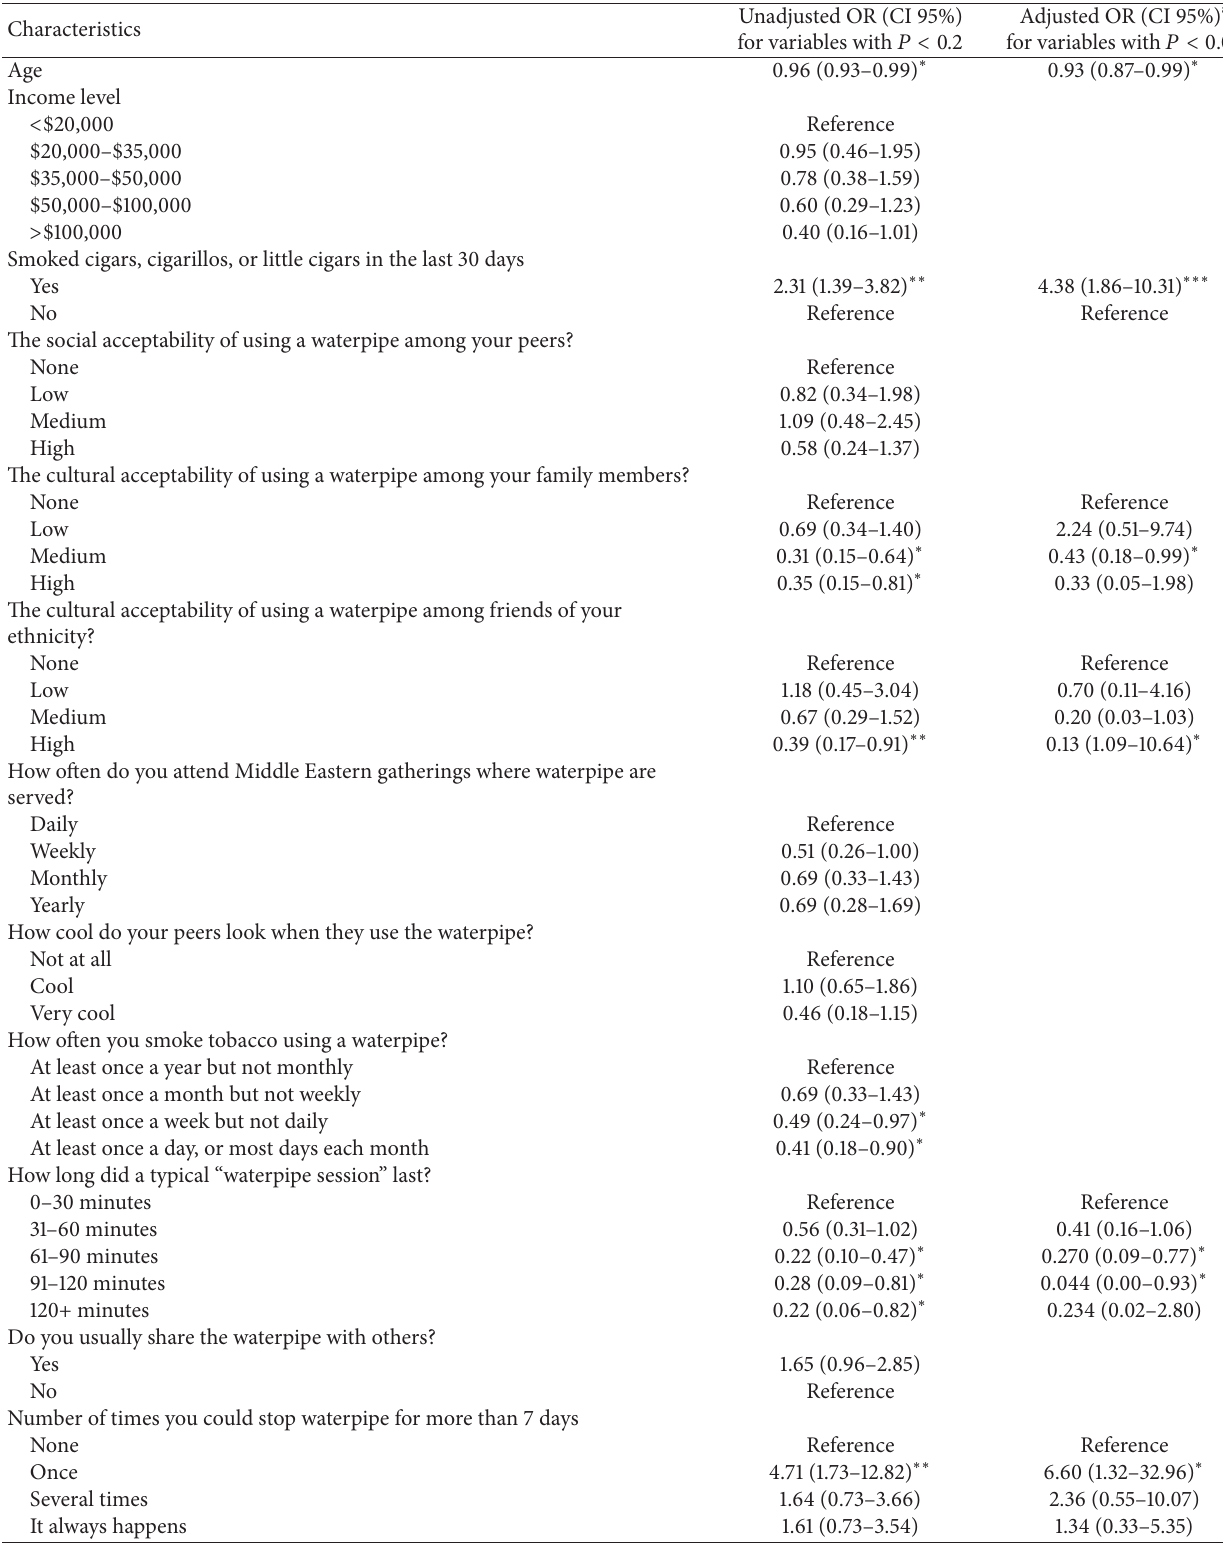
Table 5: Results of bivariate and multiple logistic regressions to predict intention to quit waterpipe